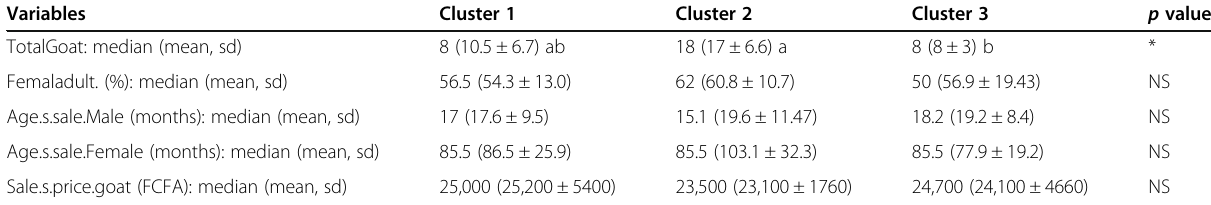
Treatments with the same letter are not significantly different between clusters NS not significant, sd standard